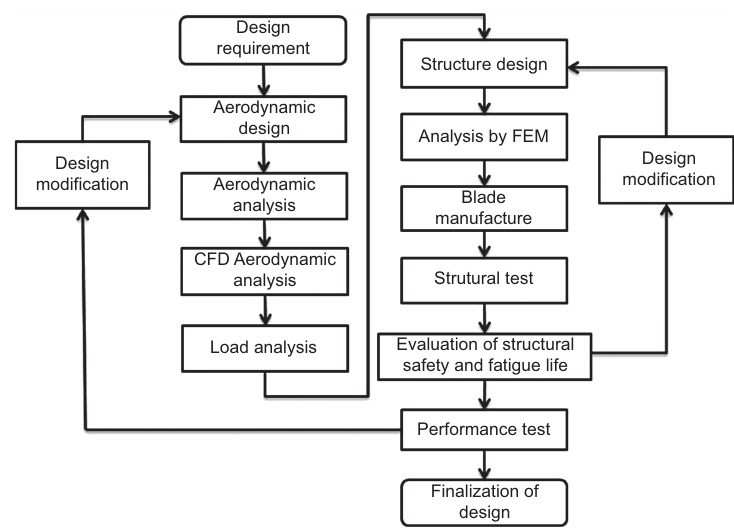
Figure 1 Proposed aerodynamic and structural design